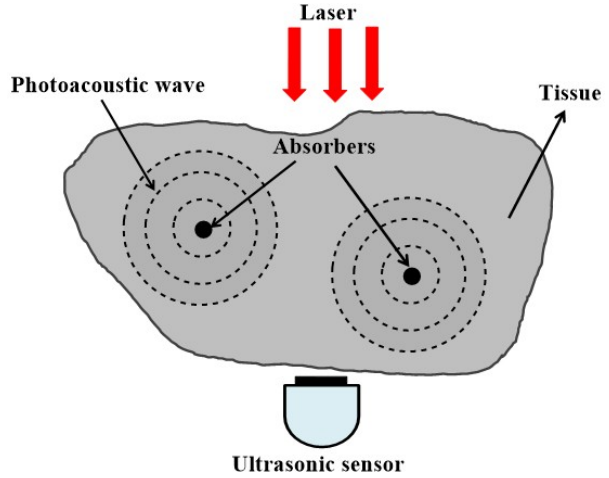
Fig. 1. The principle diagram of